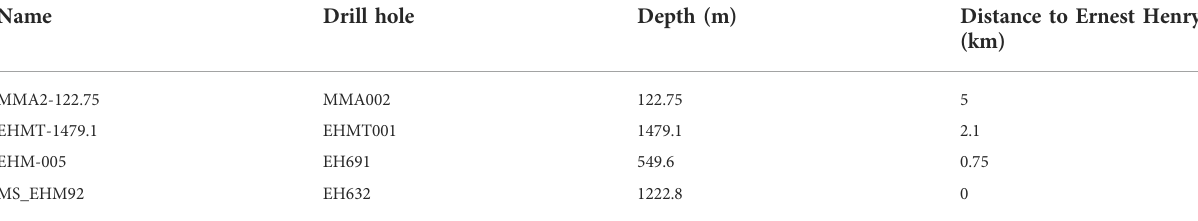
TABLE 1 Apatite sample